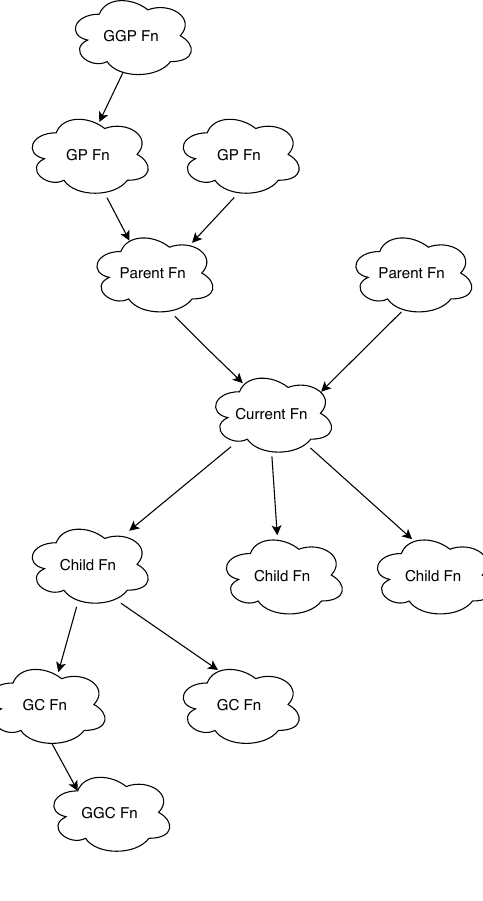
Figure 1. Function Call